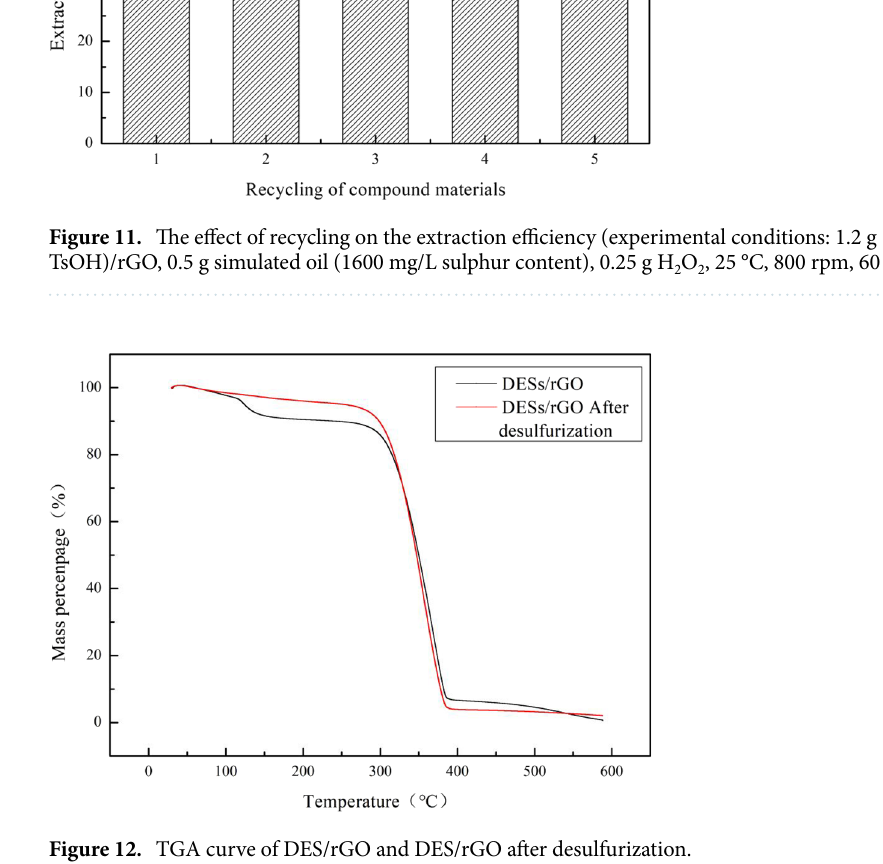
Figure 12. TGA curve of DES/rGO and DES/rGO after